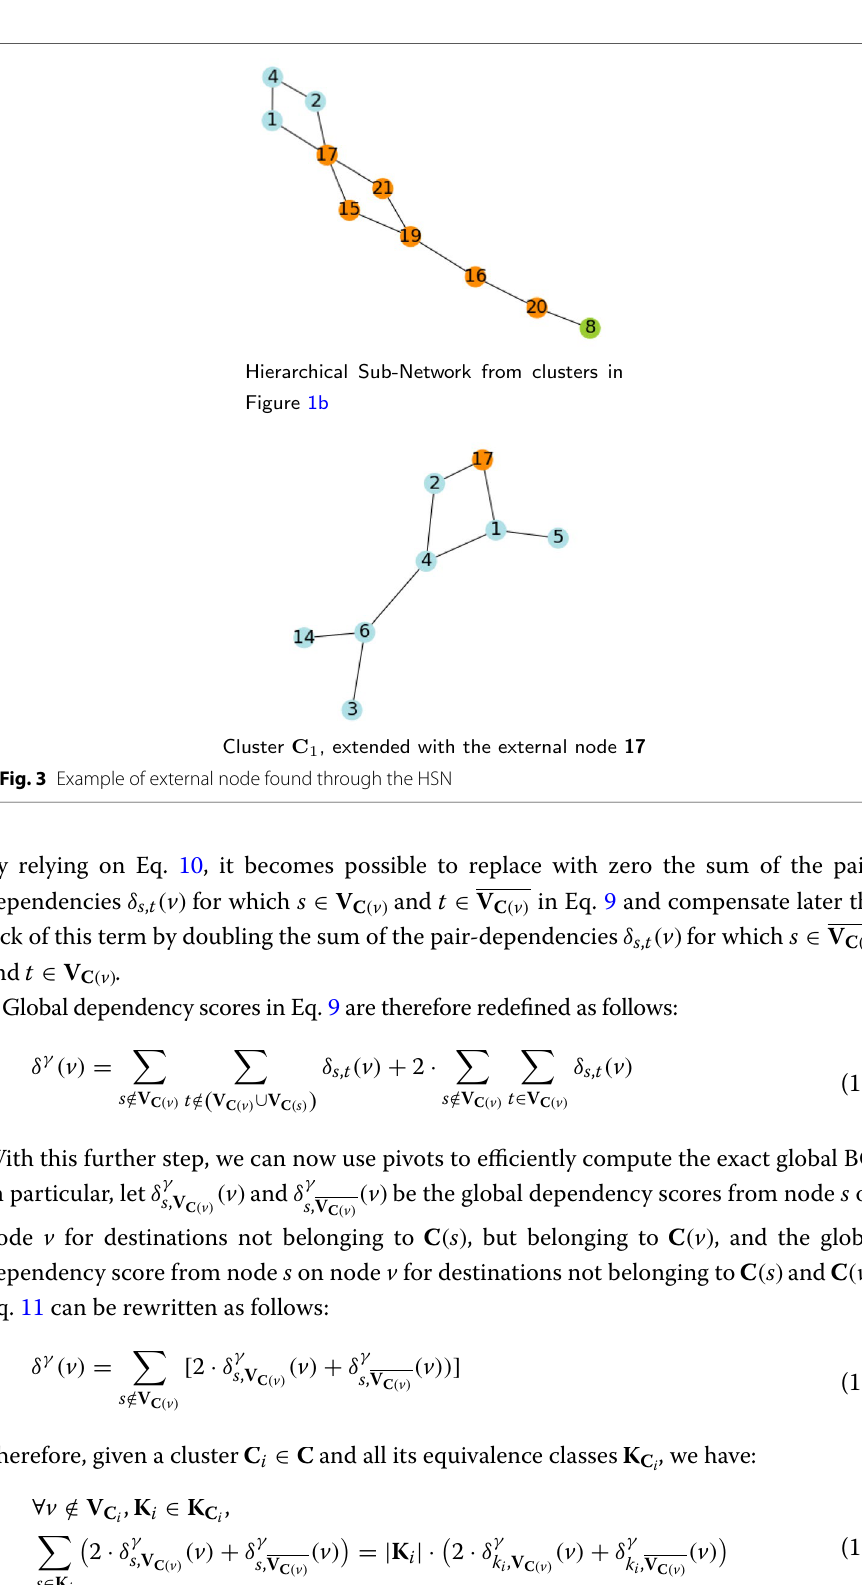
Hierarchical Sub-Network from clusters in Figure 1b